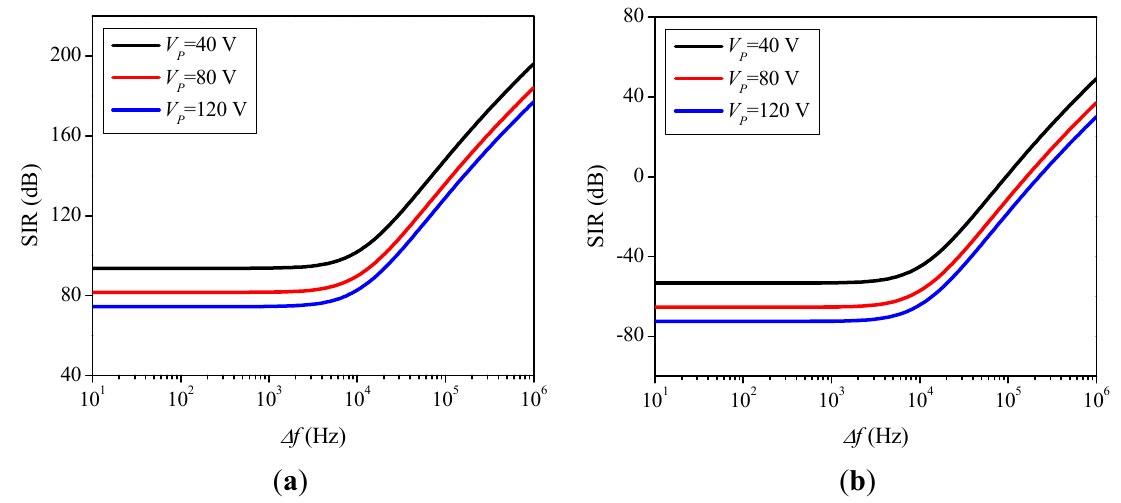
Figure 12. Signal-to-intermodulation ratio (SIR) as a function of the frequency offset for EWG ring resonator with Q = 8,000, d = 90 nm and P ( b ) P = 0 dBm. int